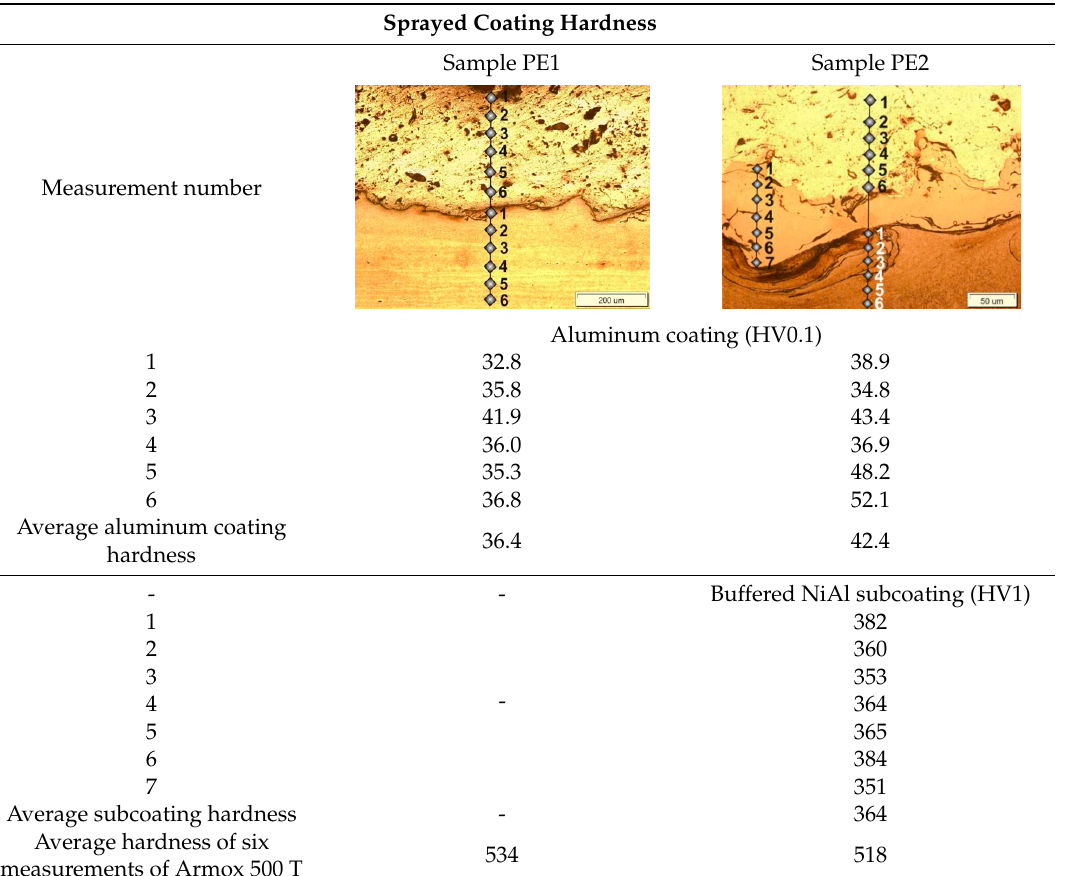
Table 5. Results of hardness measurements measured on cross-section of arc-coated aluminum coatings on Armox 500 T alloy steel.